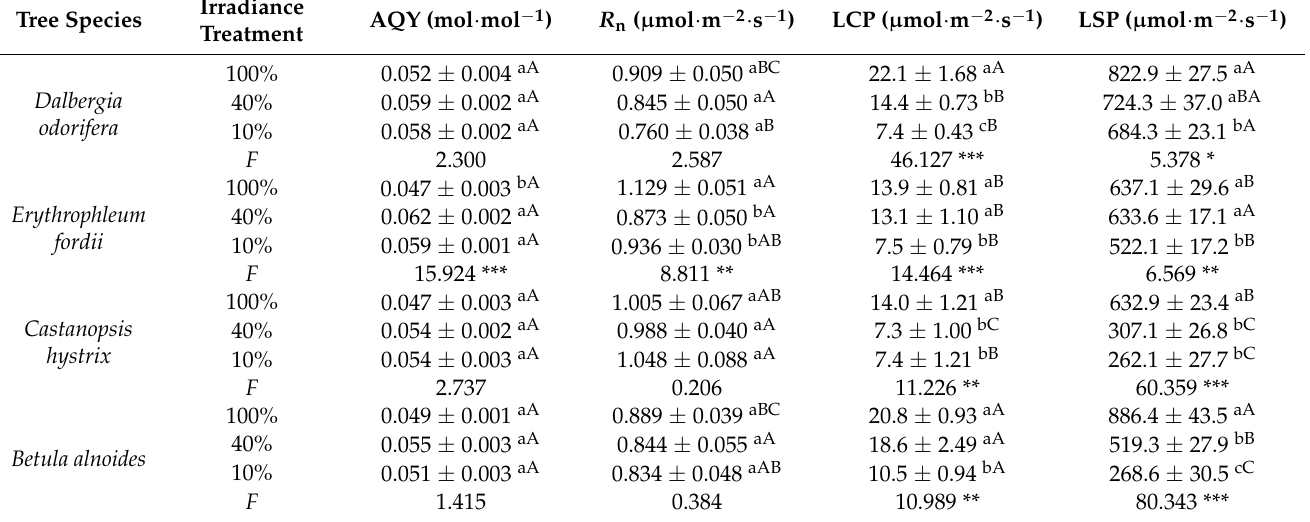
Table 5. Apparent quantum yield (AQY), dark respiration ( R n ), light compensation point (LCP) and light saturation point (LSP) in Dalbergia odorifera , Erythrophleum fordii , Betula alnoides , and Castanopsis hystrix grown under three different irradiance treatments. Data are means of seven plants per treatment ± SE. Lower case letters indicate significant difference at 0.05 levels among the irradiance treatments, whereas capital letters indicate significant difference at 0.05 levels among species under same irradiance treatment. F -ratios with statistically significant values denoted by * p < 0.05, ** p < 0.01, *** p < 0.001 among irradiance